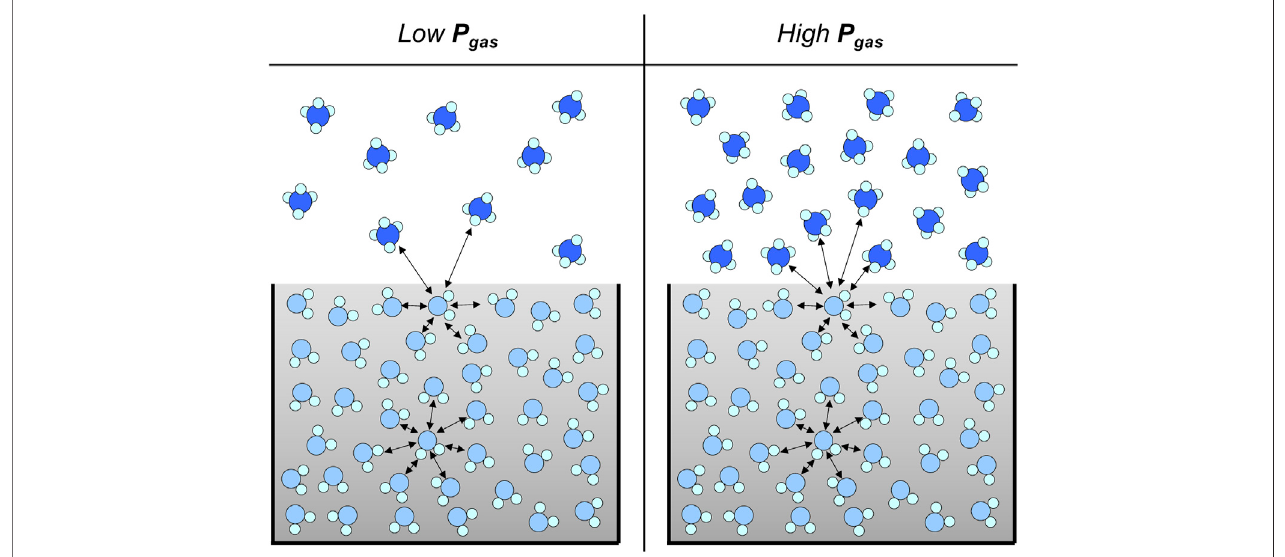
FIGURE1| Interfacialtension.Intermolecularforcesattheinterfacebetweenaliquidandagastodemonstratethattheinterfacialtensiondecreaseswithincreasing gas pressure.